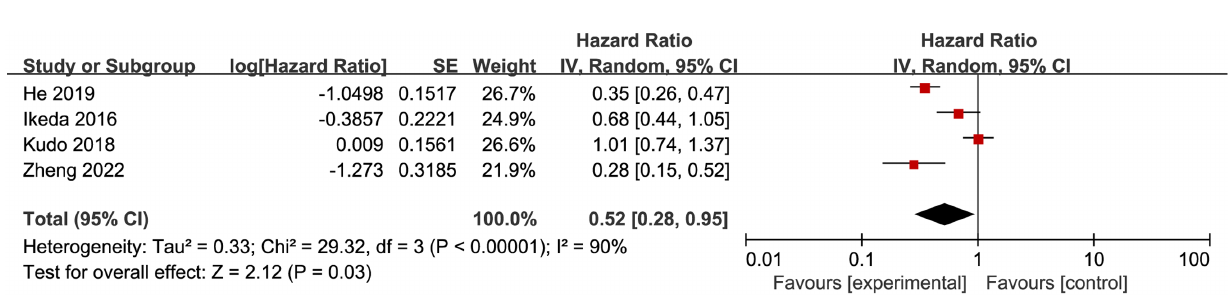
Figure 3. Forest plot comparing hazard ratios for overall survival between the SoraHAIC and sorafenib groups. SoraHAIC, sorafenib plus hepatic arterial infusion